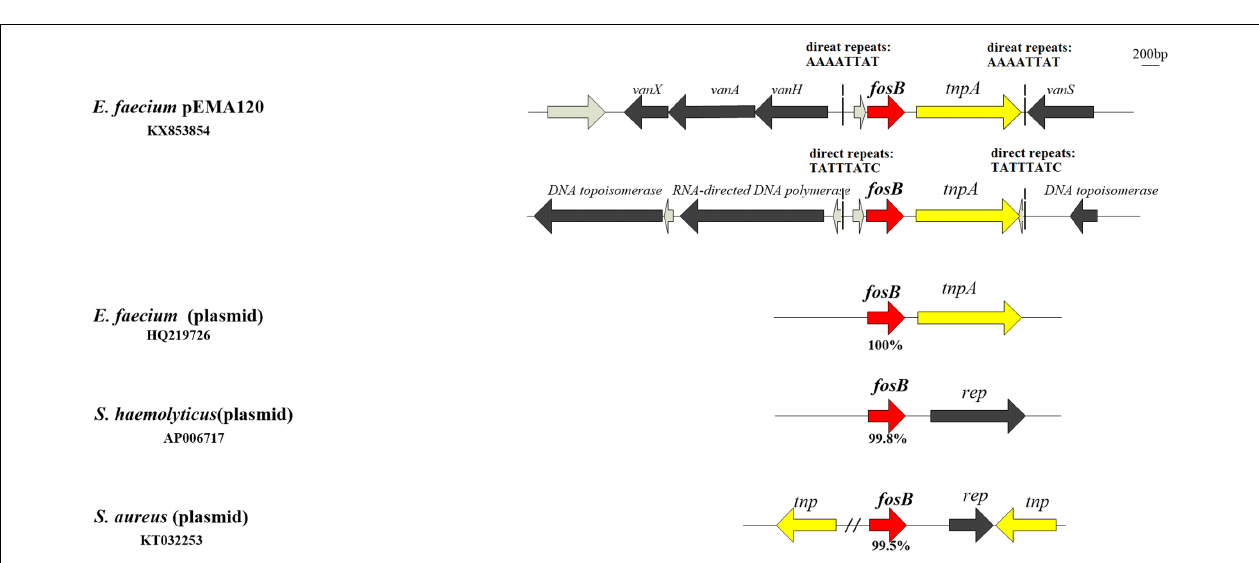
containing the same two copies of fosB as well as a Tn 1546